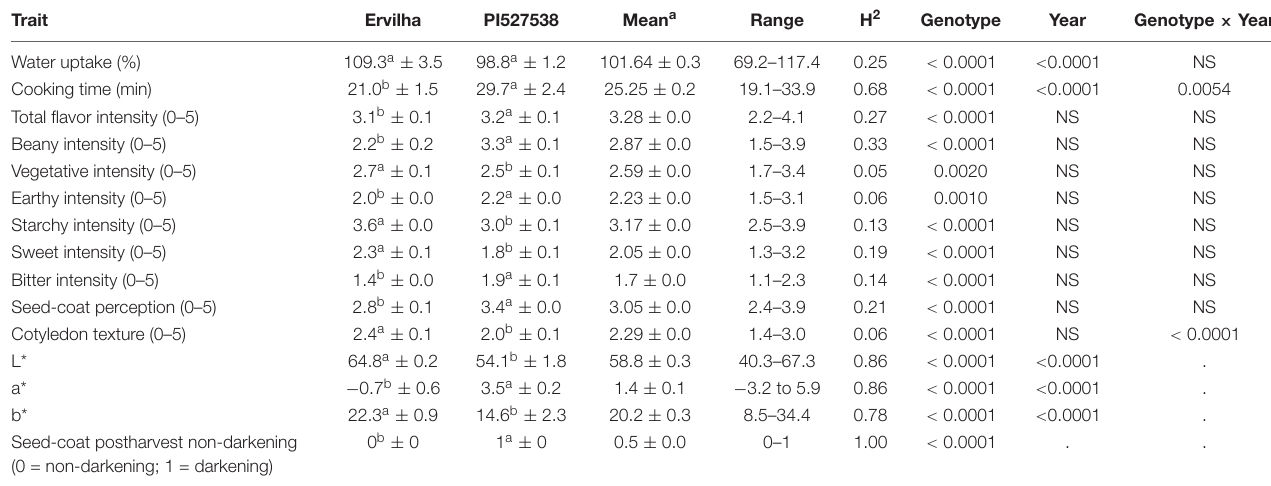
TABLE 1 | Parental phenotypes, means with standard error, ranges, and broad-sense heritability (H 2 ) estimates for the RILs for both years combined with ANOVA p -values for genotype, year, and genotype by year indicated.